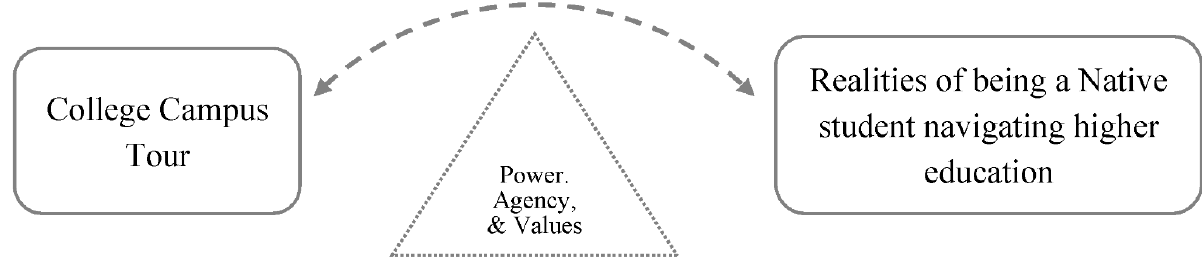
Figure 4. Power, agency, and values.